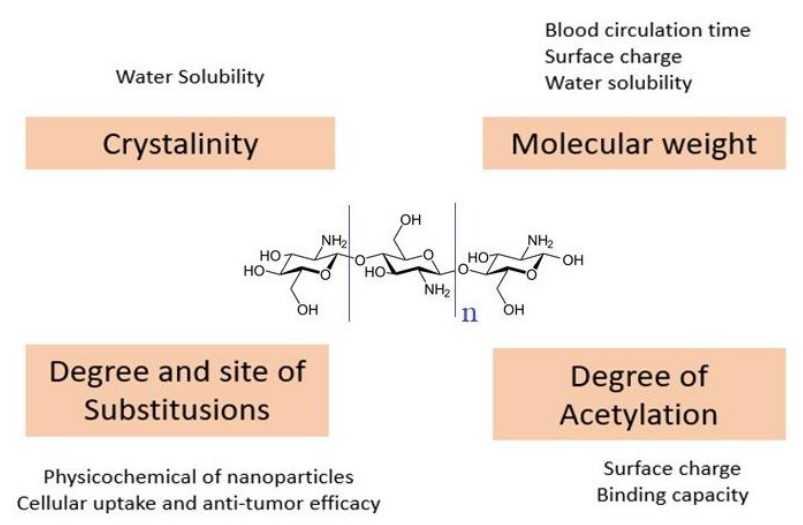
Figure 5. Chitosan structural features and their impacts on chitosan-based nanoparticles. Cellular uptake and zeta potential were decreased with the decrease of Mw and DD [38]. With the rising amount of chitosan, the surface charge increased [59–61]. Chi- tosan’s beneficial properties are LMW chitosan, a high DA, a diameter of 100 nm and